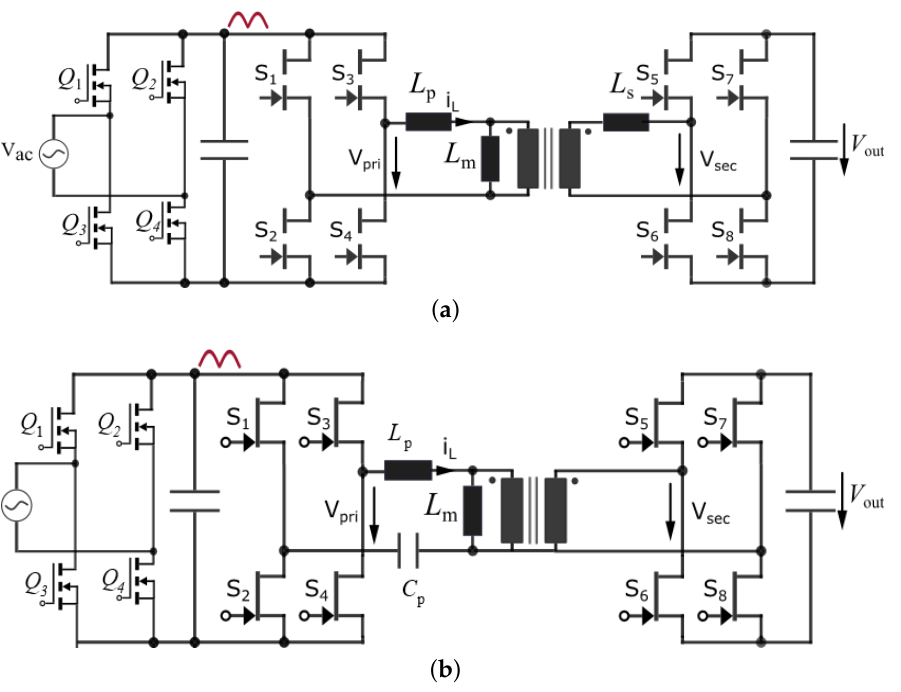
Figure 15. Single-phase single-stage ( a ) dual active bridge (DAB) AC/DC converter proposed by [110] and ( b ) series-resonant DAB AC/DC converter proposed by